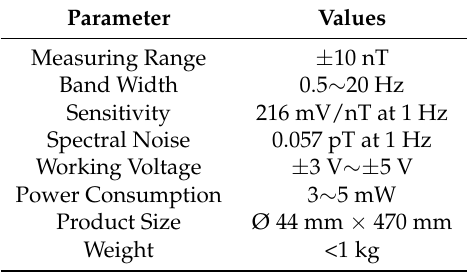
Figure A1. The key performance parameters of the inductive magnetic sensor versus the frequency. ( a ) Sensitivity; ( b ) Spectral density of the magnetic field noise. Table A1. The main technical parameters of the inductive magnetic